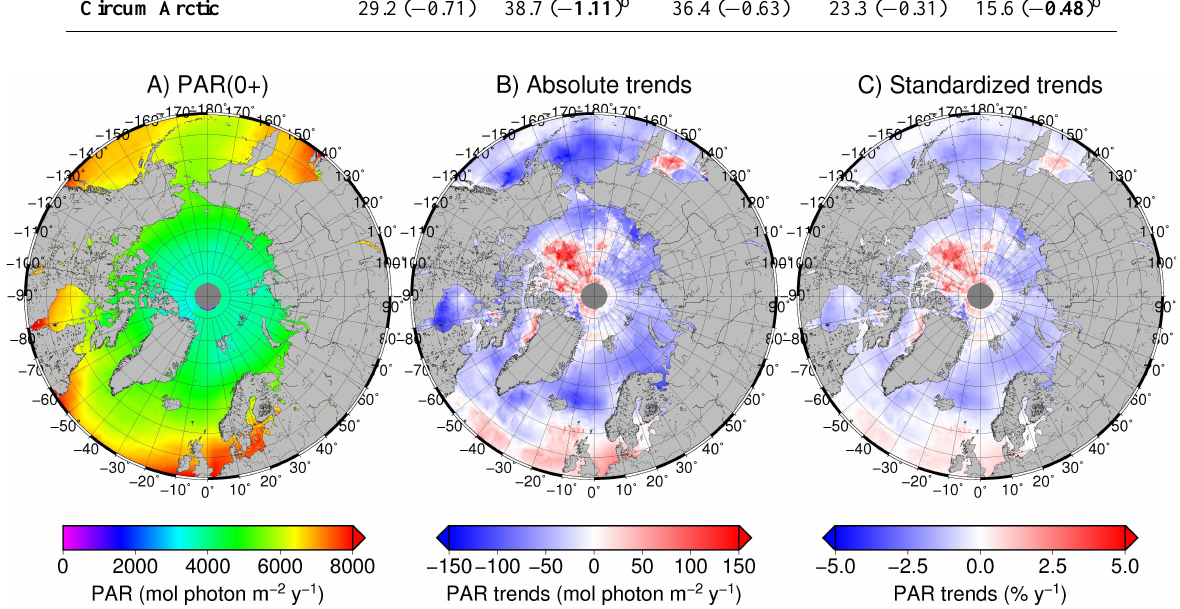
Fig. 1. (A) Mean yearly downwelling flux of PAR above the sea (ice) surface (PAR(0 + )) for the 1998 to 2009 period, (B) Absolute PAR(0 + ) trends calculated using the TSA, and (C) the standardized PAR(0 + ) trends (i.e. PAR(0 + ) trends/climatological PAR ( 0+ ) · 100).